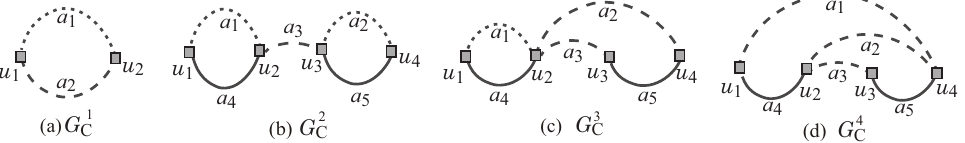
Figure 9. An illustration of seed graphs: ( a ) A monocyclic graph G 1 with two vertex-disjoint cycles; ( c ) A rank-2 cyclic graph G 3 ( d ) A rank-2 cyclic graph G 4